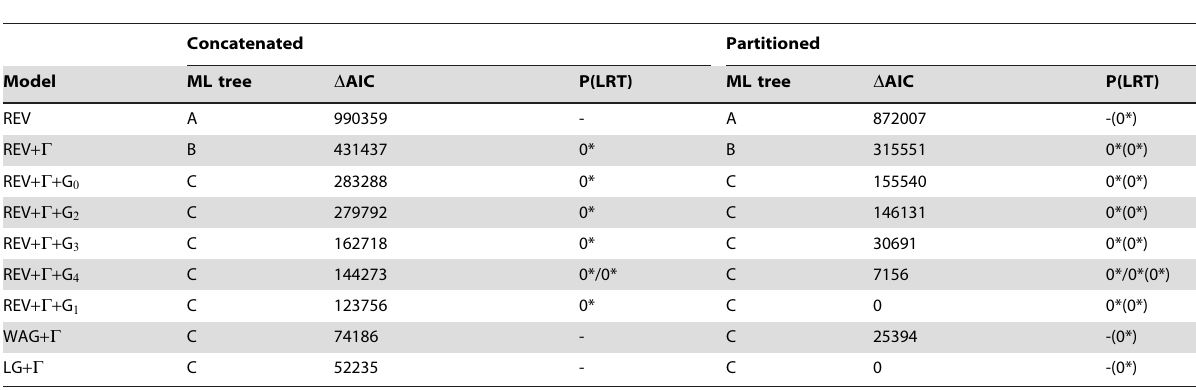
ML trees and test statistics for model tests performed on the supermatrix dataset. Models used are as in Figure 1. LRTs were performed between the model considered and the next-smallest nested model. Models with Mgene option G 4 were tested against both G 2 and G 3 models. D AIC is the difference in AIC c between a model and the best-fitting model. Partitioned models were also tested against their concatenated version (in brackets). Significant P-values ( v 0.001) are indicated by a star. Trees A and B are shown in Supplementary Figure S4.